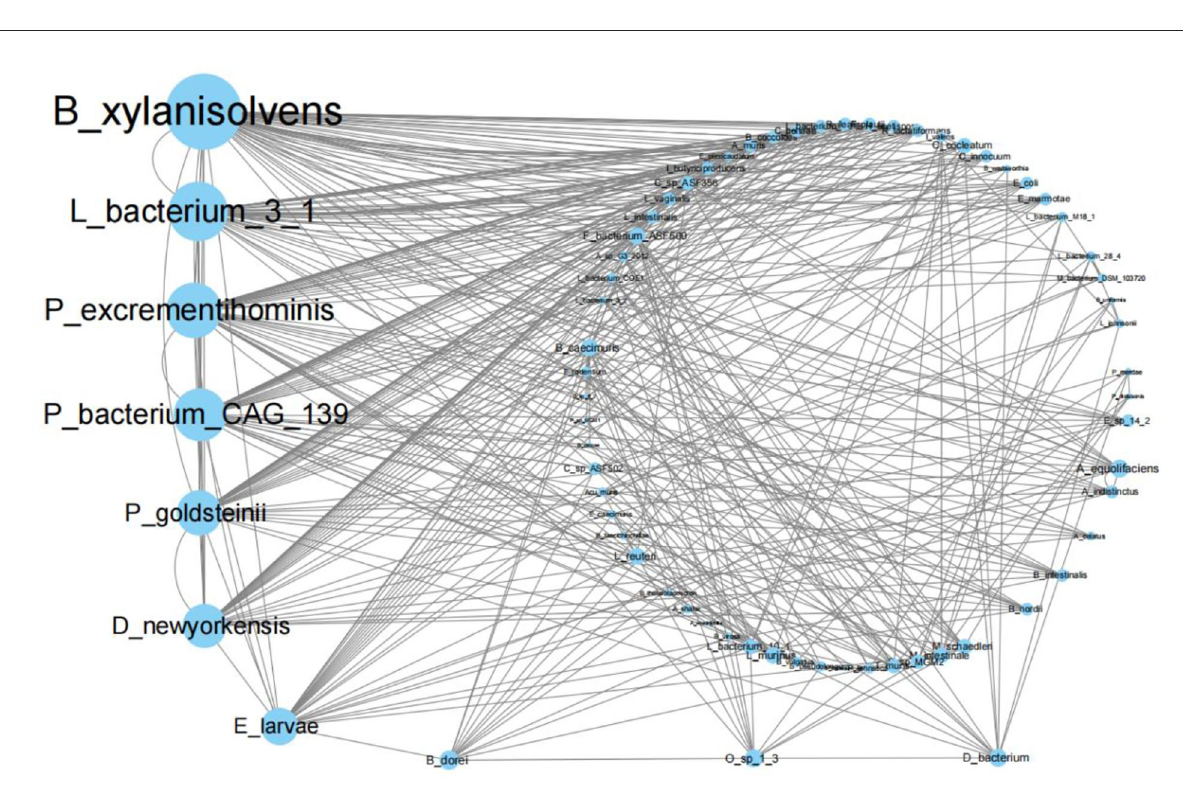
were found to have a greater effect when compared with single